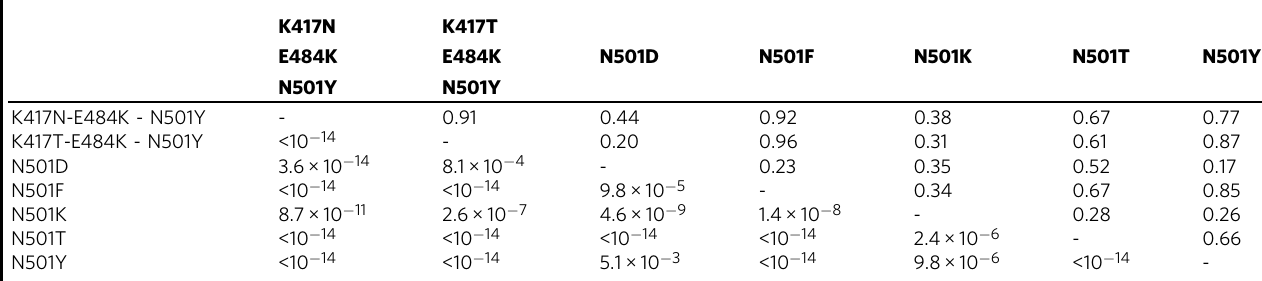
Fig. 3 Analysis of the motion of the residues of the binding region. a Root mean square fl uctuations (RMSF) of ACE2 (top) and SARS-CoV-2 spike (bottom) protein residues found in interaction during the dynamics. Different colors corresponds to different spike variants (see Table 1). b Difference between the contact probability matrices of the interacting residues between each spike variant and the Wuhan (WT) one (see Table 1). Residues are considered as interacting if the distance between their α -carbons is lower than 9 Å . Table 2 Correlation matrix between couples of variants. Correlation values (resp. p values) are reported in the upper (resp. lower) triangular